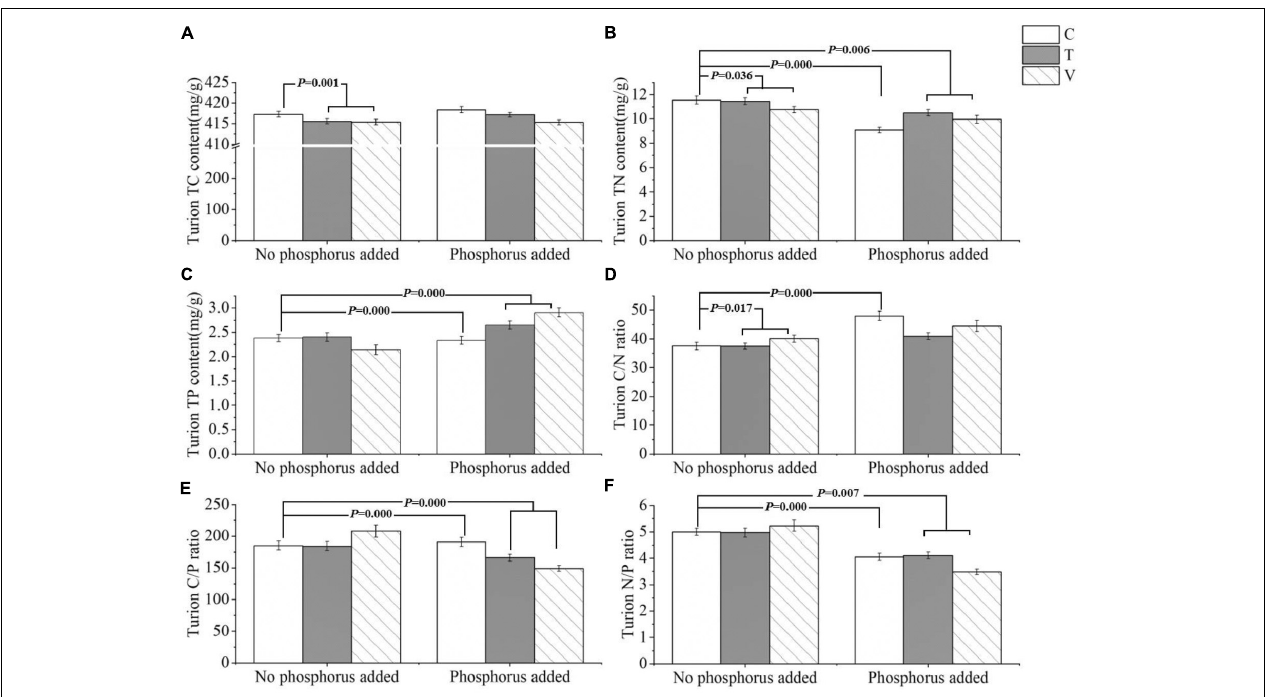
FIGURE 3 | The stoichiometric characteristics of the (A) TC, (B) TN, and (C) TP contents and the (D) C/N, (E) C/P, and (F) N/P ratios of P. crispus turions under different treatments. The C in “No phosphorus added” represent controls (C), T in “No phosphorus added” represent constant warming (T), and V in “No phosphorus added” represent variable warming (V). Meanwhile, the C in “Phosphorus Added” represent phosphorus addition (C + P), T + P in “Phosphorus Added” represent constant warming and phosphorus addition (T + P), and V + P in “Phosphorus Added” represent variable warming and phosphorus addition (V + P). TABLE 4 | Effects of different temperature scenarios and phosphorus addition on the TC, TN, and TP contents and the C/N, C/P, and N/P ratios in P. crispus seeds. Parameters Factors SS df MS F p -value